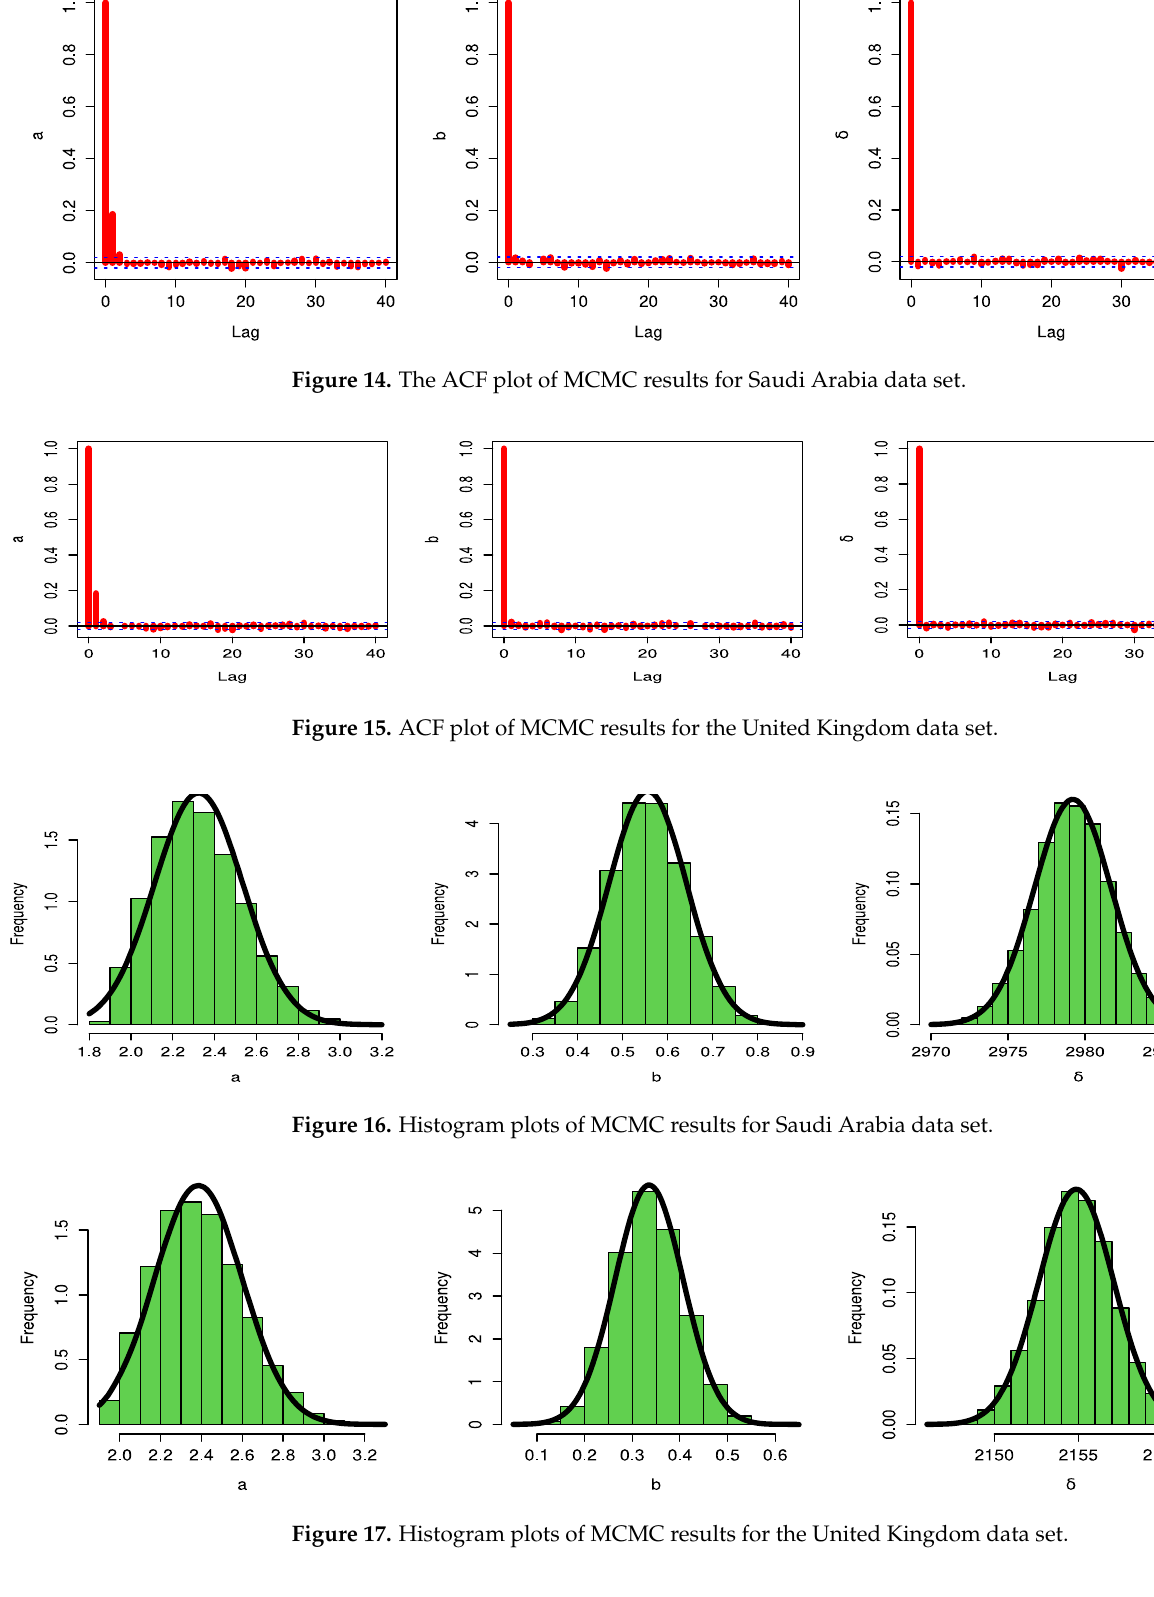
Figure 17. Histogram plots of MCMC results for the United Kingdom data set.